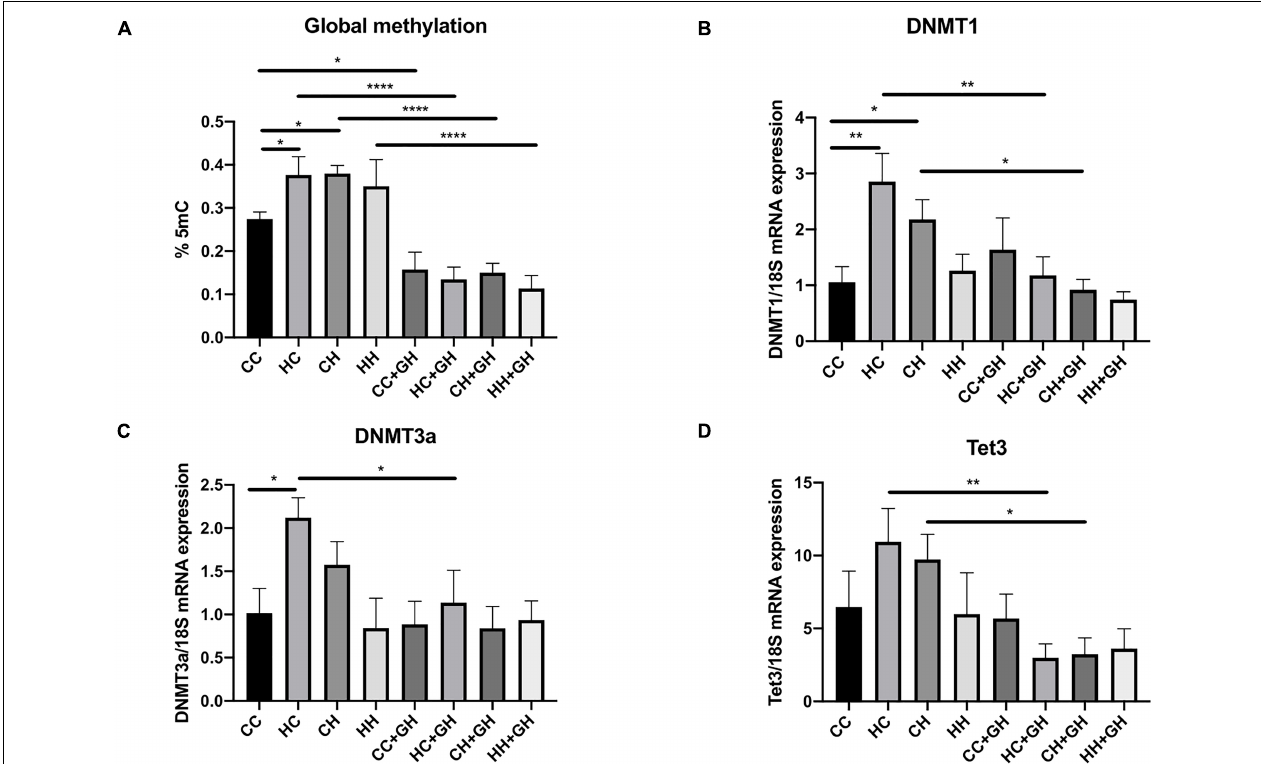
FIGURE 3 | DNA methylation markers. (A) Global methylation expressed as % 5 mC of total DNA, (B) mRNA expression of DNMT1, (C) mRNA expression of DNMT3a, (D) mRNA expression of Tet3. Results expressed as mean ± SEM, n = 4–6. * p < 0.05, ** p < 0.01, **** p < 0.0001. CC, control offspring; HC, lean offspring of obese mothers; CH, obese offspring of lean mothers; HH, obese offspring of obese mothers; CC + GH, control offspring exposed to gestational hydralazine; HC + GH, lean offspring of obese mothers with gestational hydralazine; CH + GH, obese offspring of lean mothers with gestational hydralazine; HH + GH, obese offspring of obese mothers with gestational